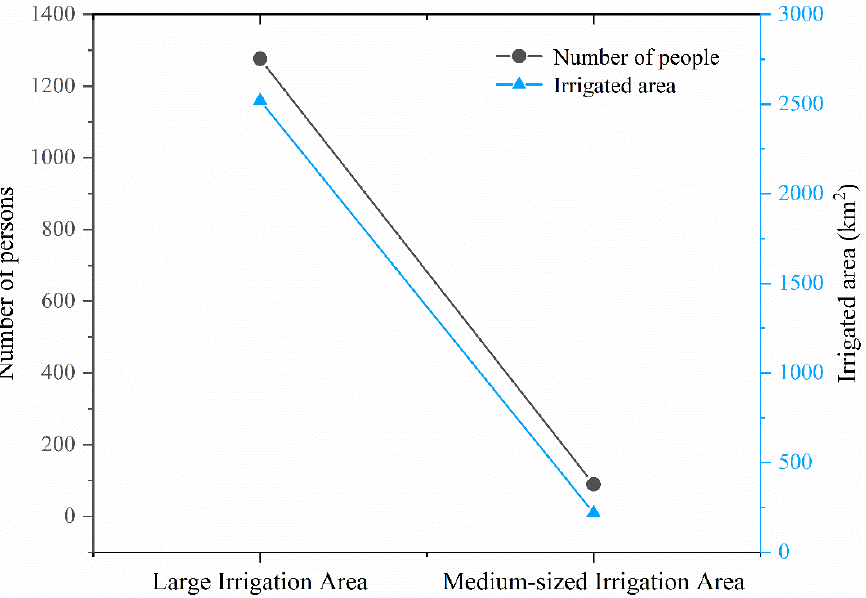
Figure 10. The number of grassroots water conservancy-related personnel and irrigated area in different types of irrigation areas.